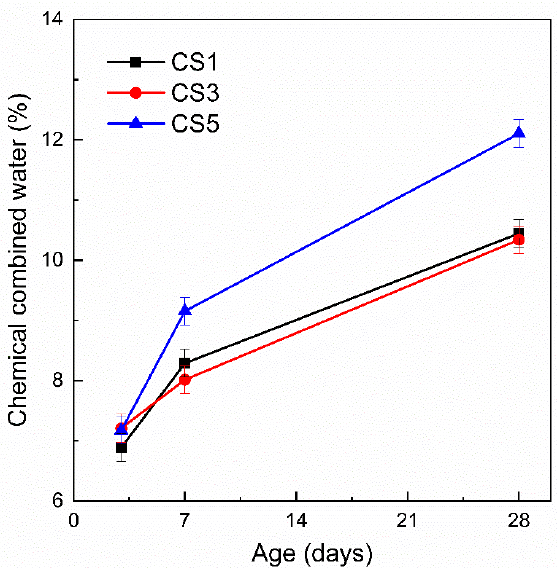
Figure 12. CH content of slag pastes at different ages determined by TGA.